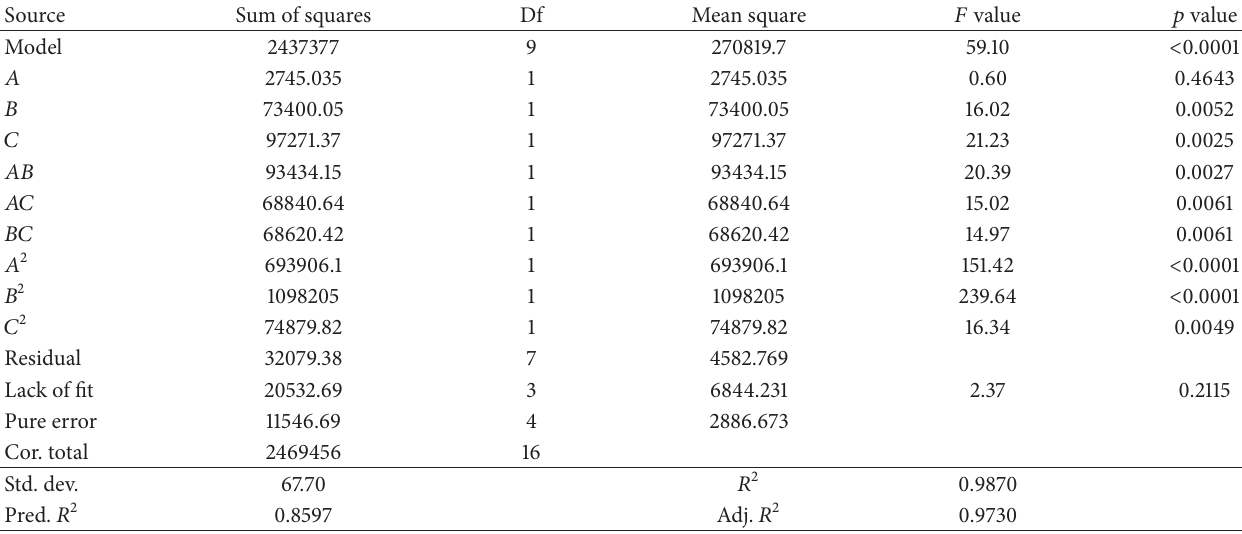
Table 2: Variance analysis of experimental results of RSM.